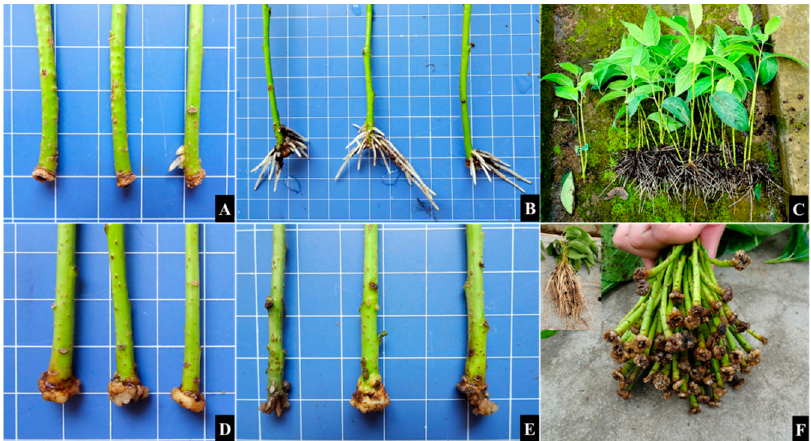
Figure 4. Morphological characteristics in rooting process of E. ulmoides cuttings. ( A – C ) The rooting situation of cuttings on the 22nd, 39th and 53rd day of E. ulmoides ‘Huazhong 6 ′ . ( D – F ) The rooting situation of cuttings on the 22nd, 39th and 53rd day of E. ulmoides ‘Huazhong 8 ′ .